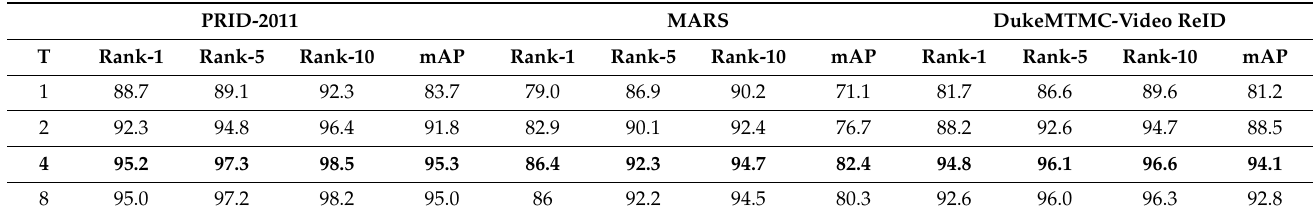
Table 4. Performance comparison of different video sequence lengths.